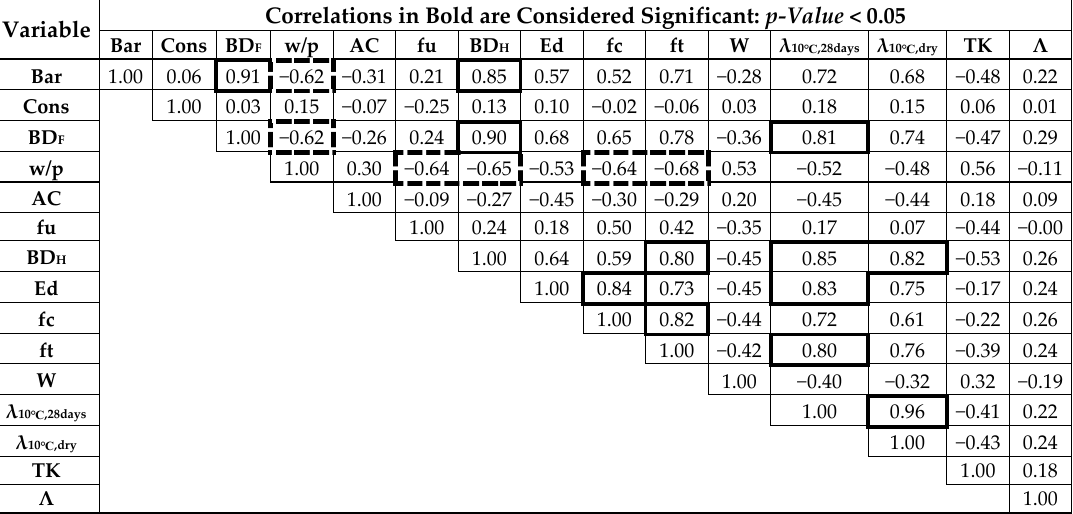
Table 6. Matrix with the linear correlation coefficients between pairs of variables. Correlations in bold are considered significant: p-value < 0.05 Variable